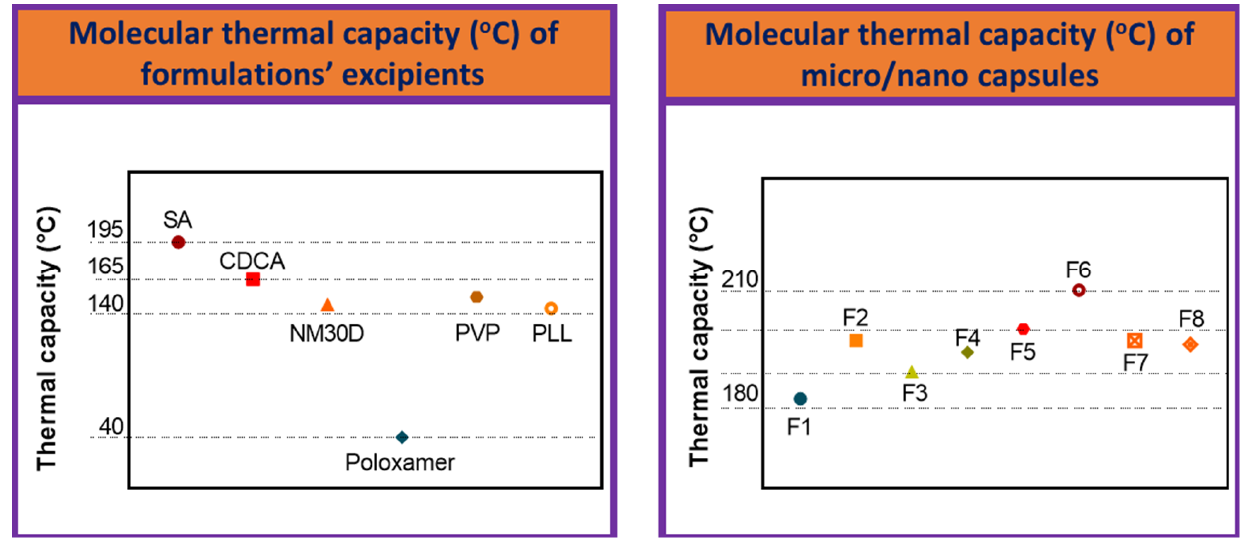
Figure 5. Molecular thermal capacity (°C) of formulation excipients ( left ) and micro/nano capsules ( right ). Data are mean ± standard error of the mean, n = 3.